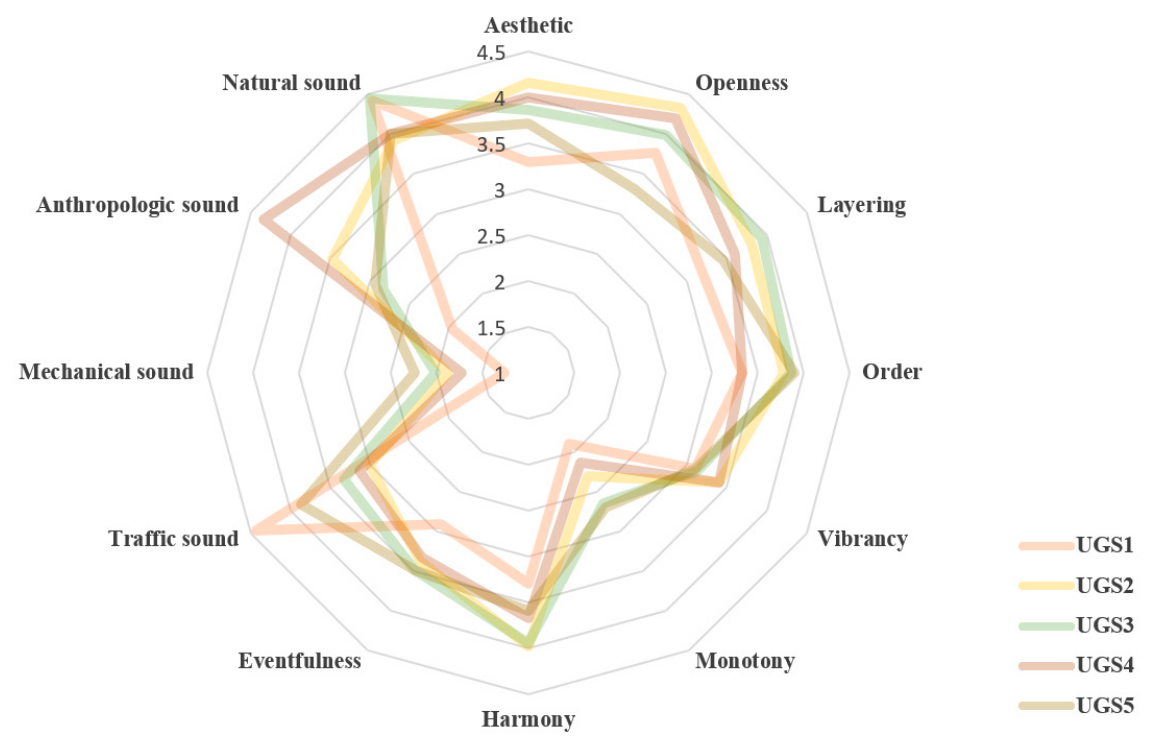
Figure 2. The evaluation results of the five study sites.